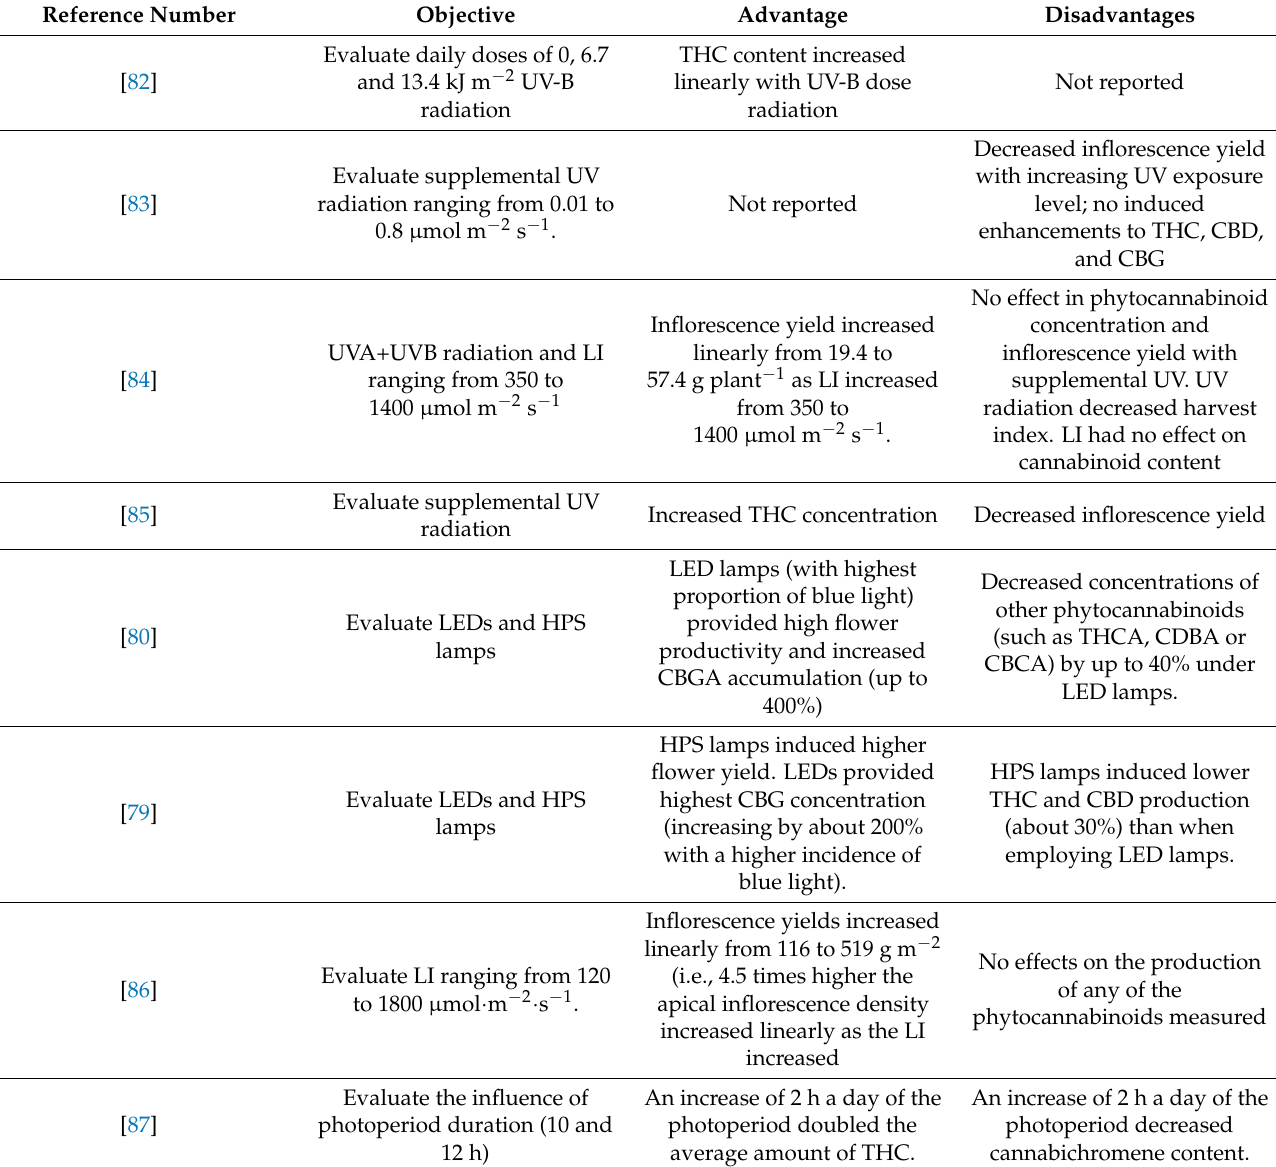
Table 1. The most relevant studies in relation to the effects, advantages, and disadvantages of different sources of light and radiation for phytocannabinoid production (LI: light